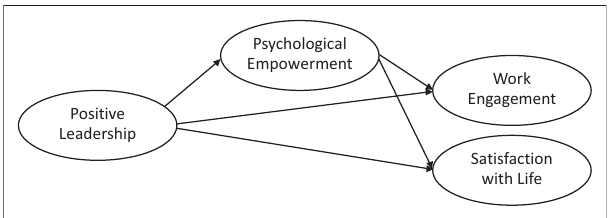
FIGURE 1: The hypothesised research